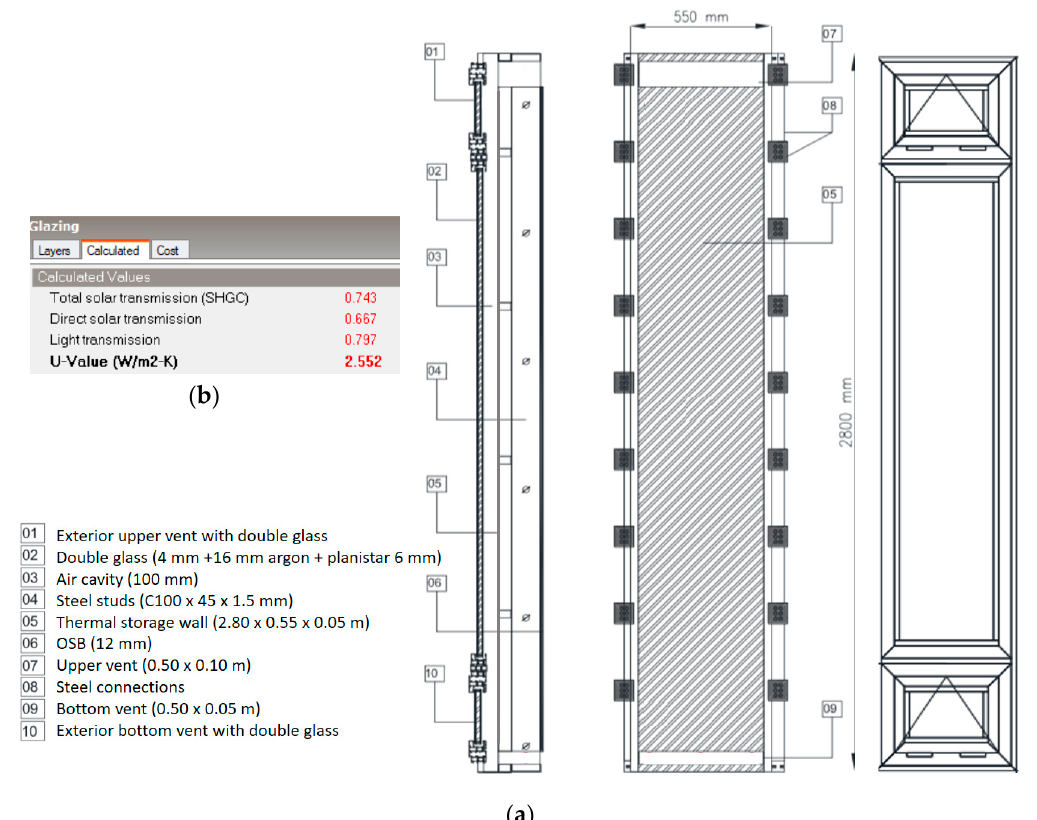
Figure 3. Trombe wall prototype: ( a ) Schematic geometry details (adapted from [36]); ( b ) Glazing optical and thermal properties.